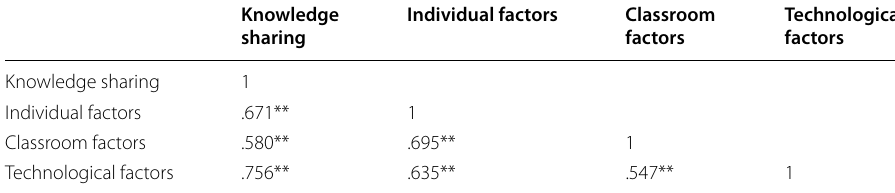
Table 5 The relationship between individual, class, and technological factors with knowledge sharing